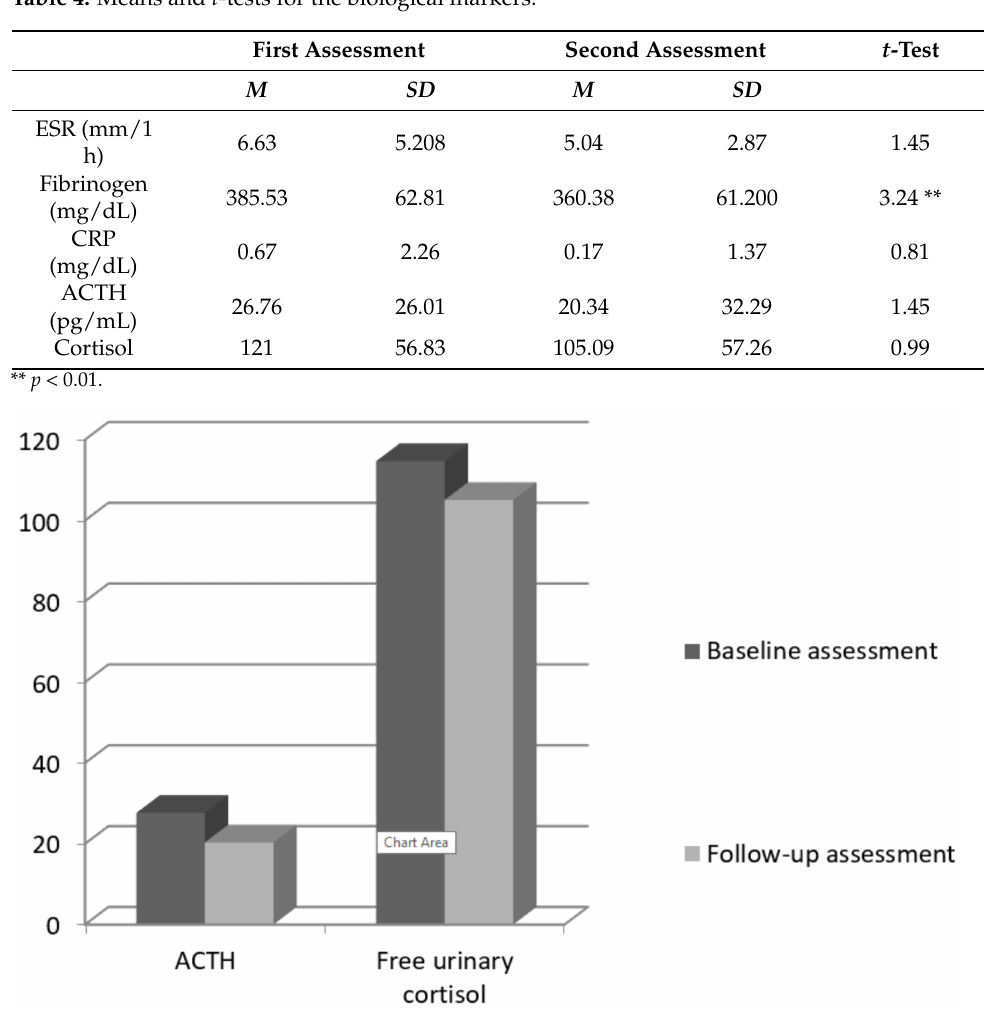
Table 4. Means and t -tests for the biological markers.